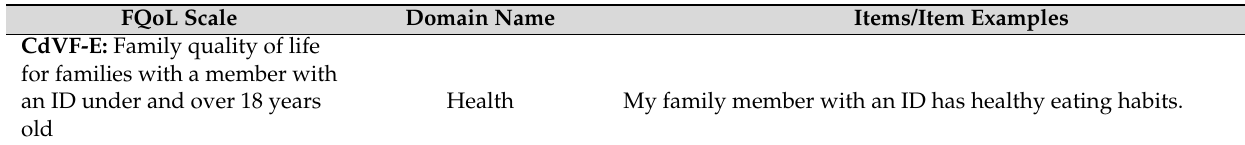
Table 4. Items/item examples considered in the domain of health within each FQoL